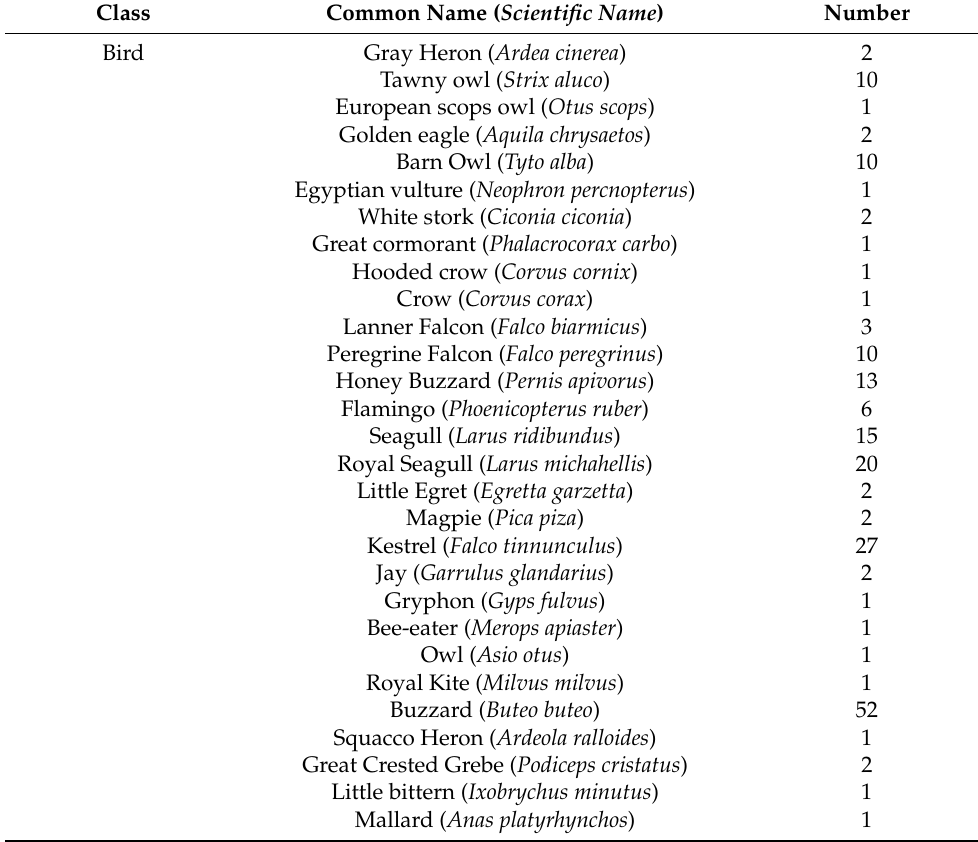
Table 2. The wild animal species